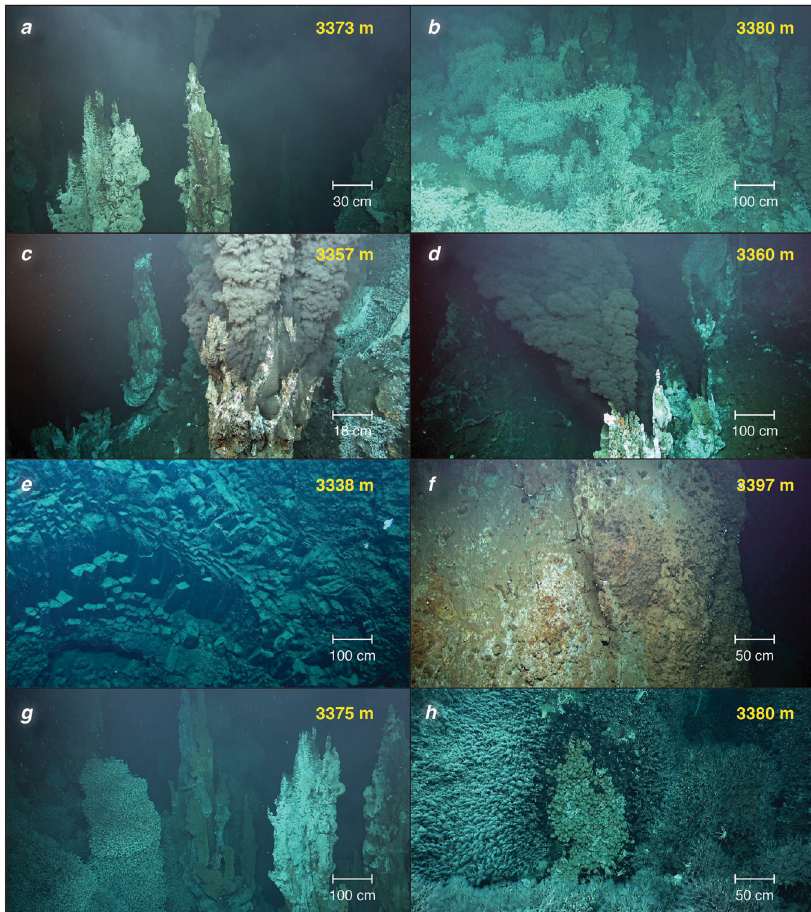
Fig. 4 La Scala Vent Field. a , b Chimney cluster ( ‘ Pandora Site ’ ), SE of the vent fi eld at 3380 m depth characterized by a few black smokers and predominant weakly diffusive vents. This site is surrounded by cirripeds to the West, North and East. c , d Second site ( ‘ Corto Site ’ ) located on the fl ank of a cliff controlled by a N55-60 fault. The South area at 3360 m depth is the most active of the hydrothermal fi eld. e Massive prismatic lava. f Highly altered basalts due to past high temperature hydrothermal circulation. g Large colonies of Vulcanolepas sp. colonizing inactive chimneys. h A patch of Alviniconcha endosymbiotic gastropods surrounded by Ifremeria nautilei and Vulcanolepas